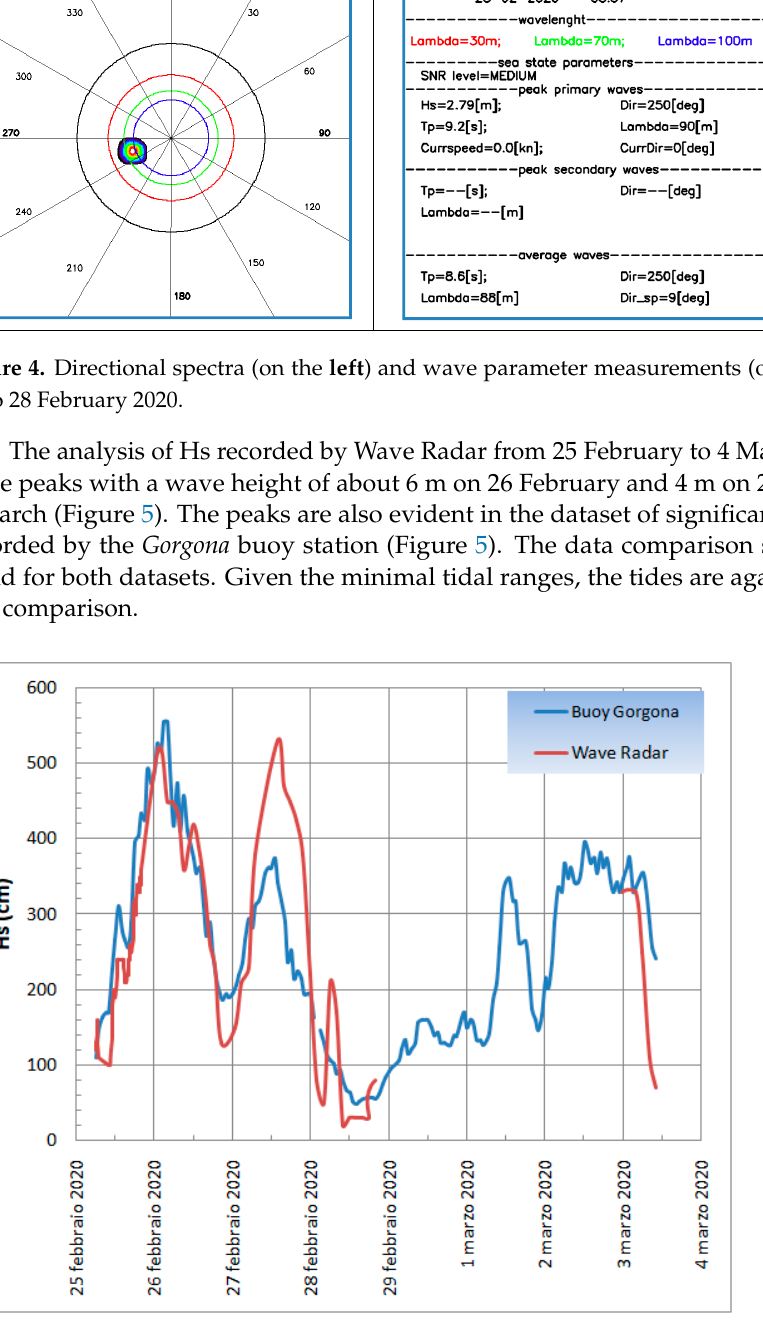
Figure 5. Mean wave height measurements recorded by the Gorgona wave buoy (blue) and Wave Radar (red). Radar